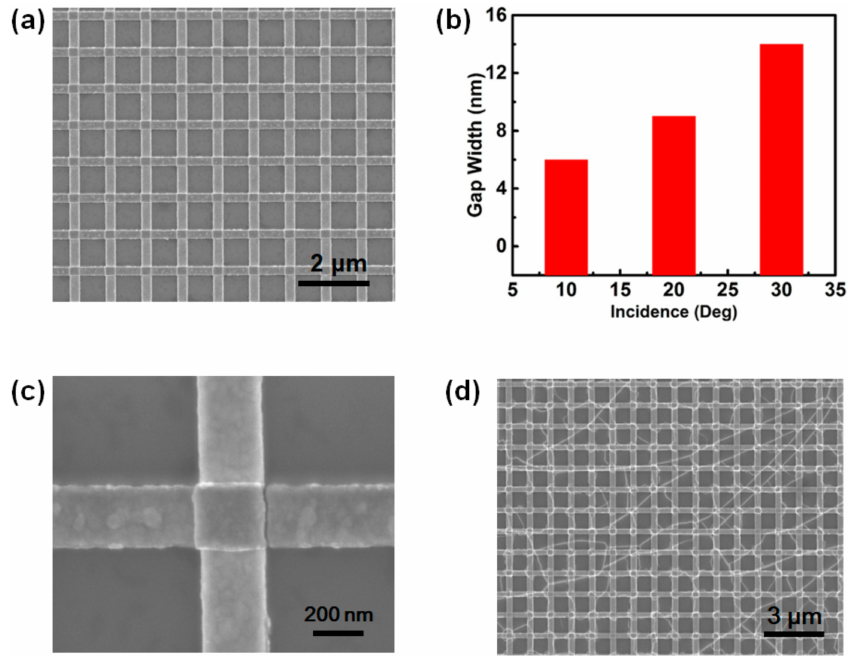
Figure 2. ( a ) scanning electron microscope (SEM) image of 10-nm nanogap arrays fabricated using